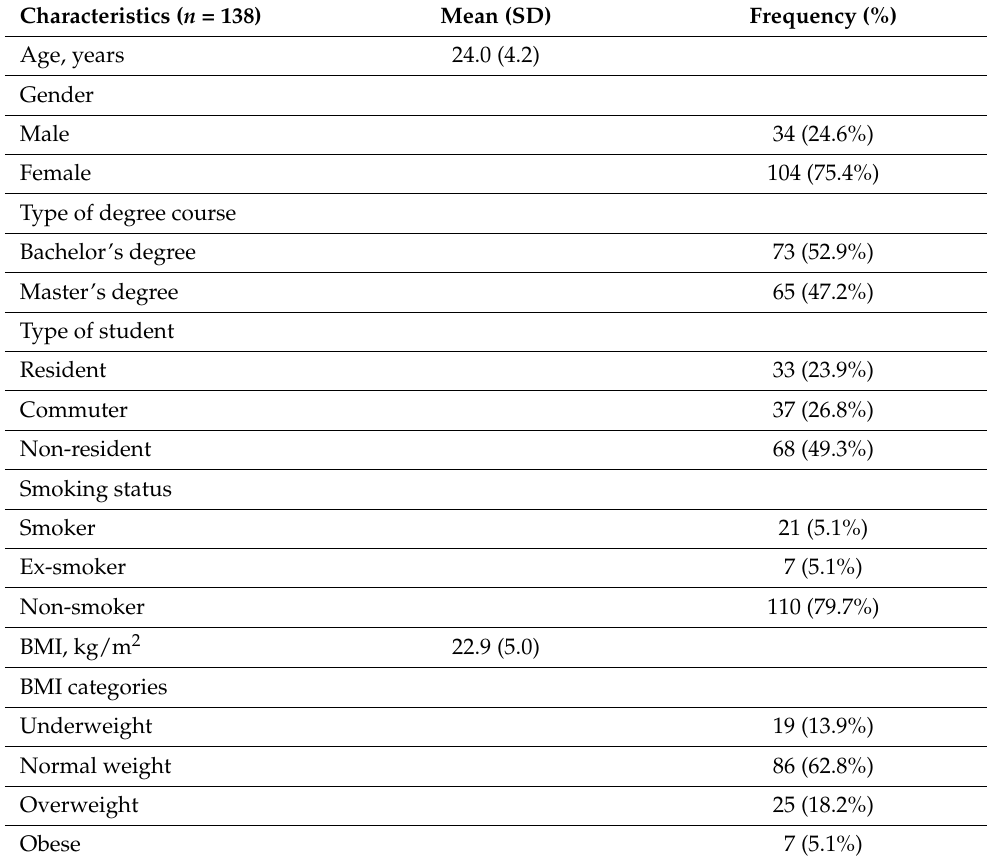
Table 1. Characteristics of the study